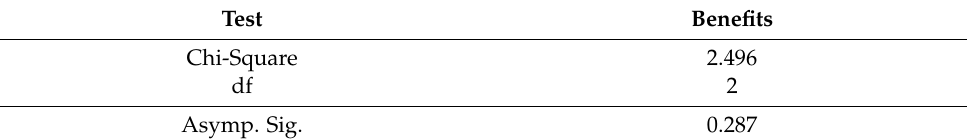
Table 7. Chi square value is not significant: test